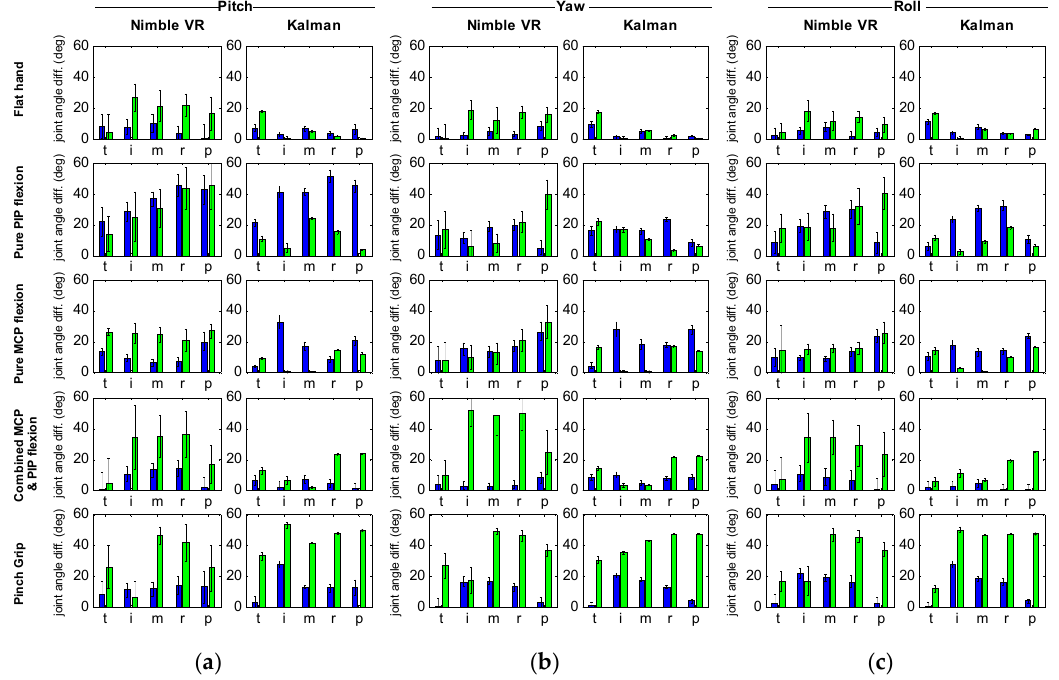
Figure 3 . Precision and accuracy for all fingers of the hand model and for all orientation ranges. ( a ) Pitch range; ( b ) Yaw range; ( c ) Roll range. For each graph, the absolute difference is given between the mean calculated joint angle ( i.e. , mean of the mean joint angles) and the true joint angle. The accompanying standard deviation is given as well ( i.e. , the mean of the standard deviations at all angles), shown as ± 2·SD. Note that the values provided here are equal to the values given in the top left of the graphs in Figure 2 minus the true joint angles of the assessed hand pose. A distinction is made between the Nimble VR data (left) and the Kalman filtered date (right), as well as between the metacarpophalangeal (MCP, blue) and proximal interphalangeal (PIP, green) joint. From left to right the fingers are presented; t = thumb, i = index, m = middle, r = ring, p = pinky.